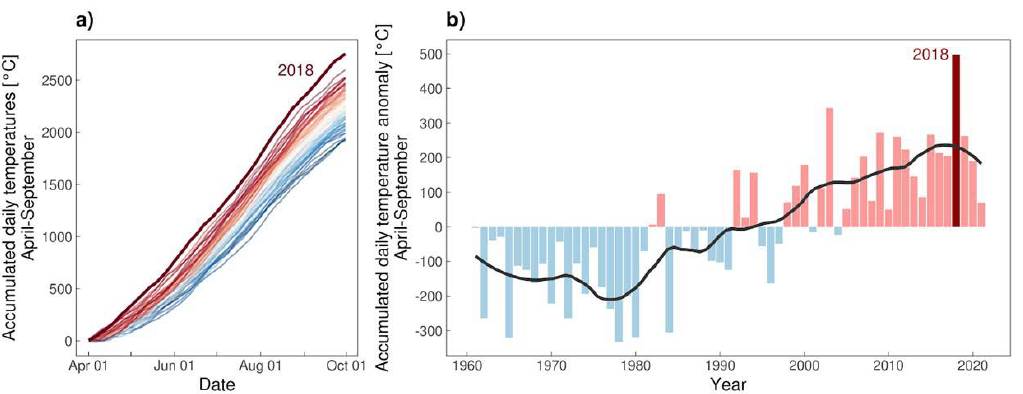
Figure 4. ( a ) Temporal evolution of accumulated daily temperatures (averaged over the Austrian domain) from April 1st to September 30th for each year from 1961 to 2021; the year 2018 is highlighted in darker red. ( b ) Accumulated daily temperature anomalies from April 1st to September 30th from 1961 to 2021 relative to the 1961 to 2020 mean; the year 2018 is highlighted in darker red.